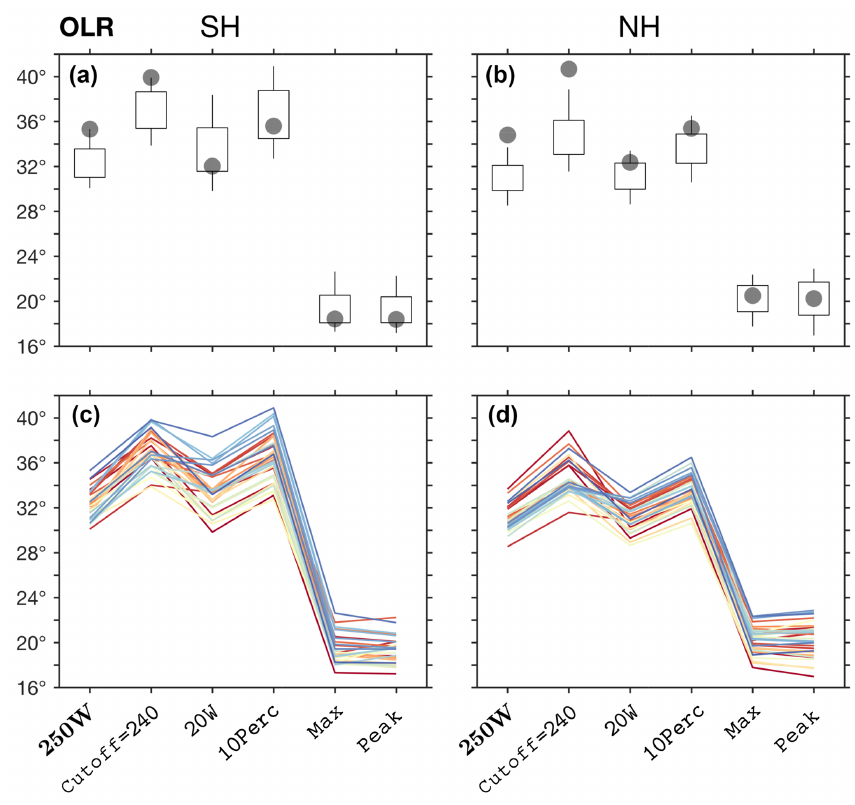
Figure 14. As in Fig. 12 for the OLR metric methods 250W , cutoff (with Cutoff=240 ), 20W , 10Perc , max , and peak